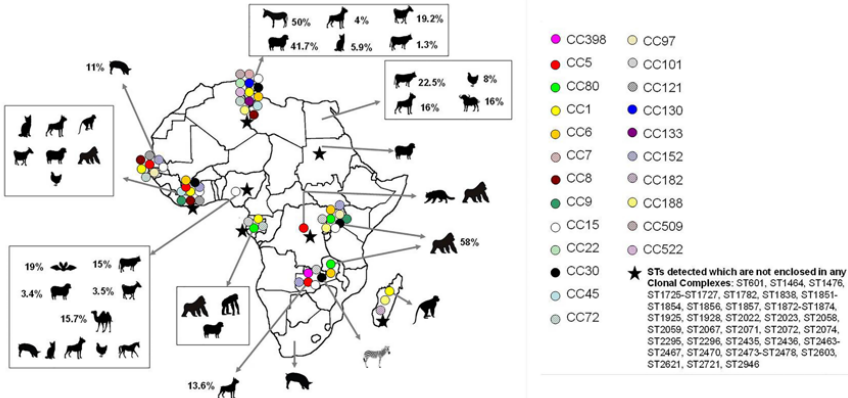
Figure 1. Animal species, clonal lineages and prevalence of MSSA identified in the Africa continent. Prevalence (%) is calculated considering the total number of samples of each animal species included in the different studies and is indicated when this estimation is possible with the data shown in each publication. Moreover, in those cases, the number of samples studied is also indicated (%/number of samples). Clonal complexes detected in more than one country are indicated as a triangle. The clonal complexes were determined by e-BURST when sequence types were indicated in the study and were presumptively assumed according to the spa -types when the sequences types were not indicated in the study.